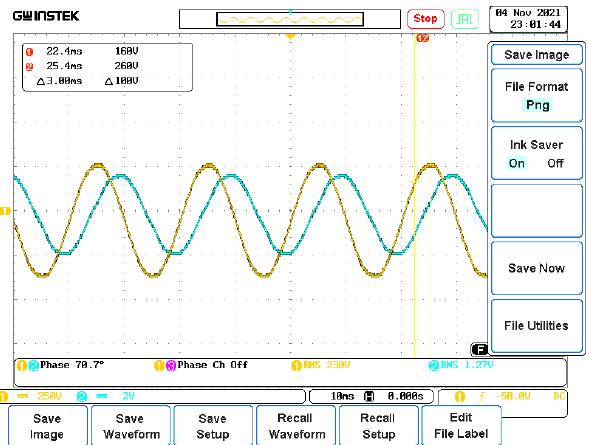
Figure 12. Experimental non-load test for winding 1 of the nine-phase IM including voltage (yellow line) and current (blue line).